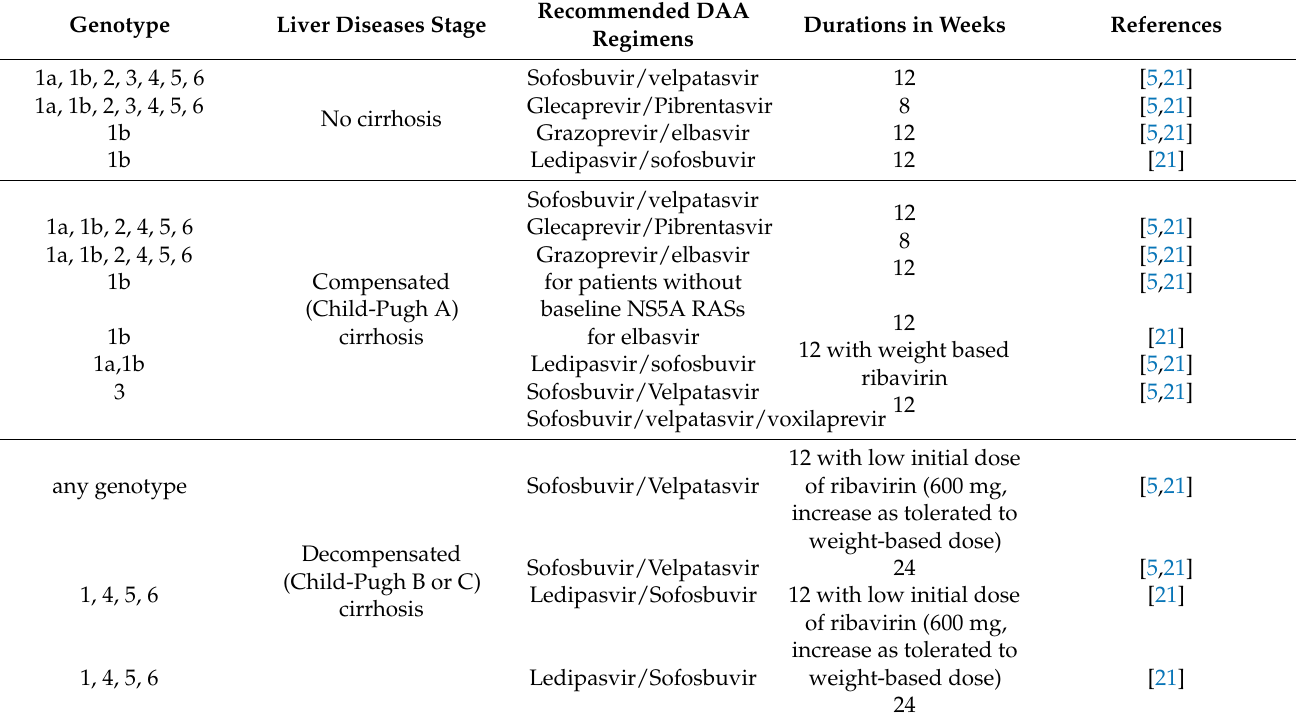
Table 1. Therapeutic options in patients with HCV infection naive to DAAs